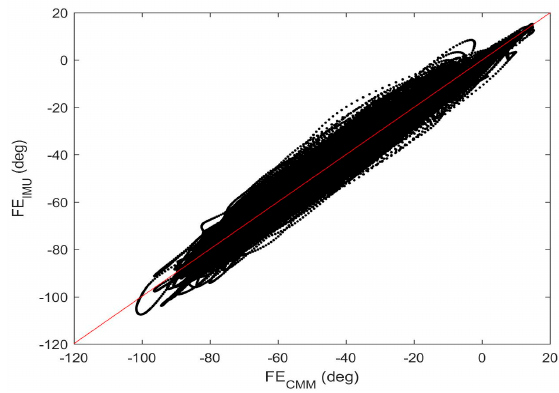
Figure 8. Correlation of the results for the combined 3D rotation trials. IMU-estimated flexion/extension plotted against the corresponding truth data from optical encoder. The red line is the linear fit.